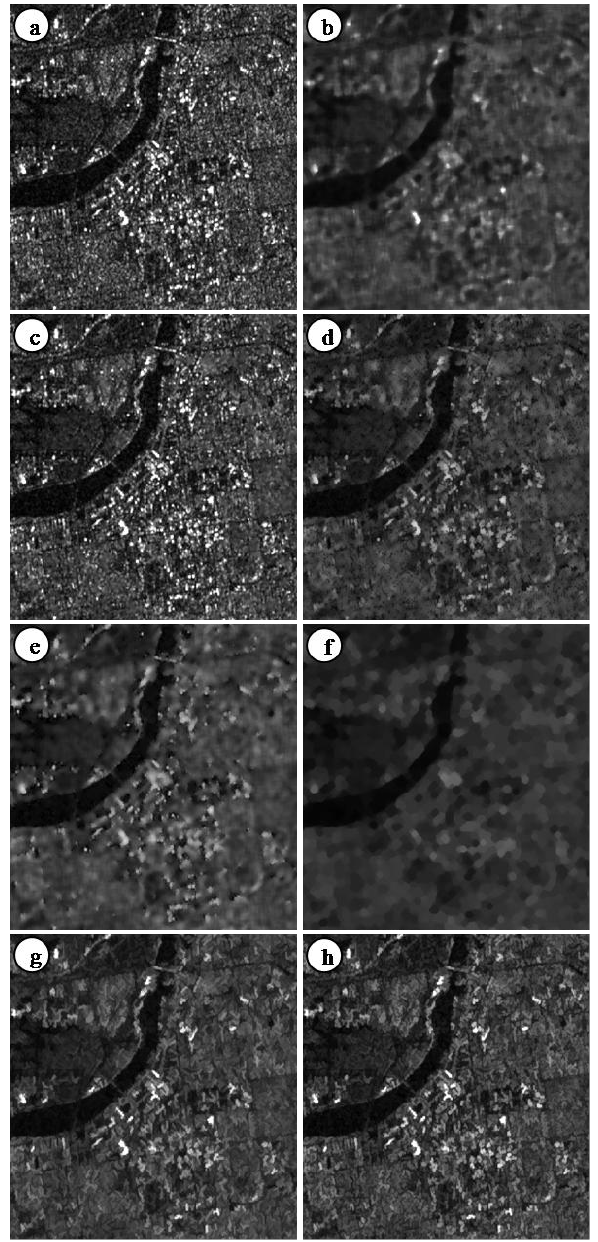
Figure 8. A detailed image of an urban area; a) the original Radarsat-2 image and the results of its filtration, using: b) Median filter, c) Frost filter, d) Lee-sigma filter, e) Gamma- MAP filter, f) SAF, g) MSE filter, h) MSE filter by reconstruction; size of mask (SE) for all filters: